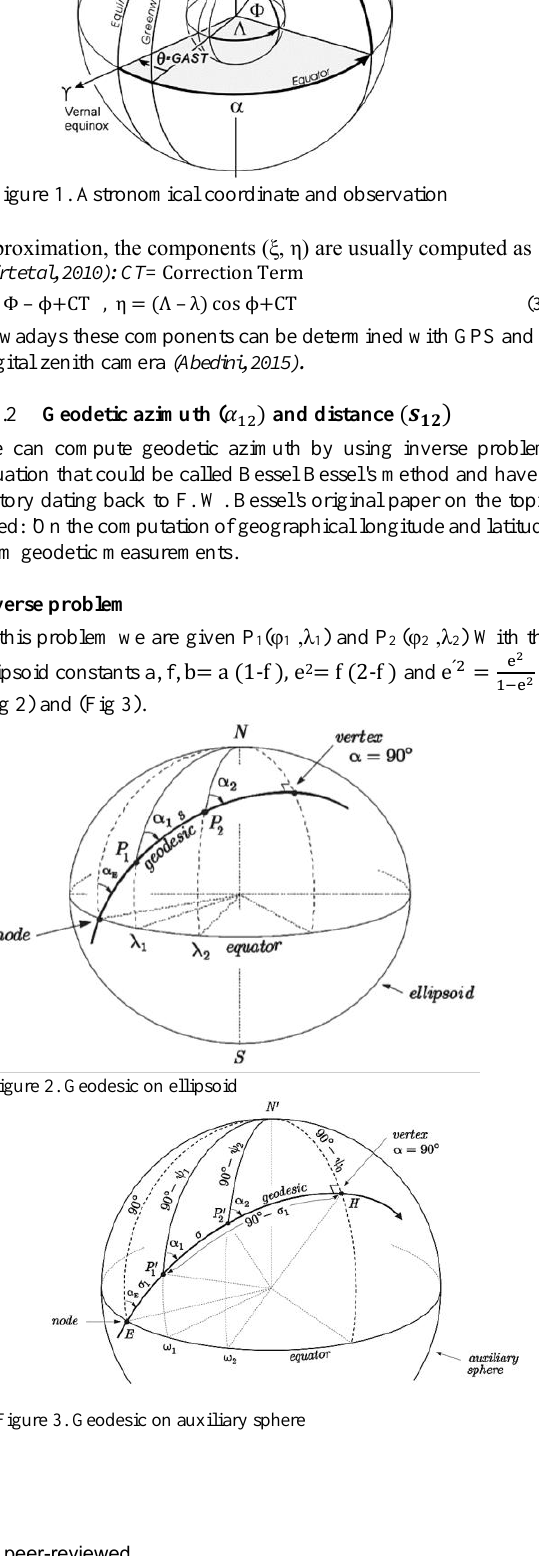
Figure 3. Geodesic on auxiliary sphere